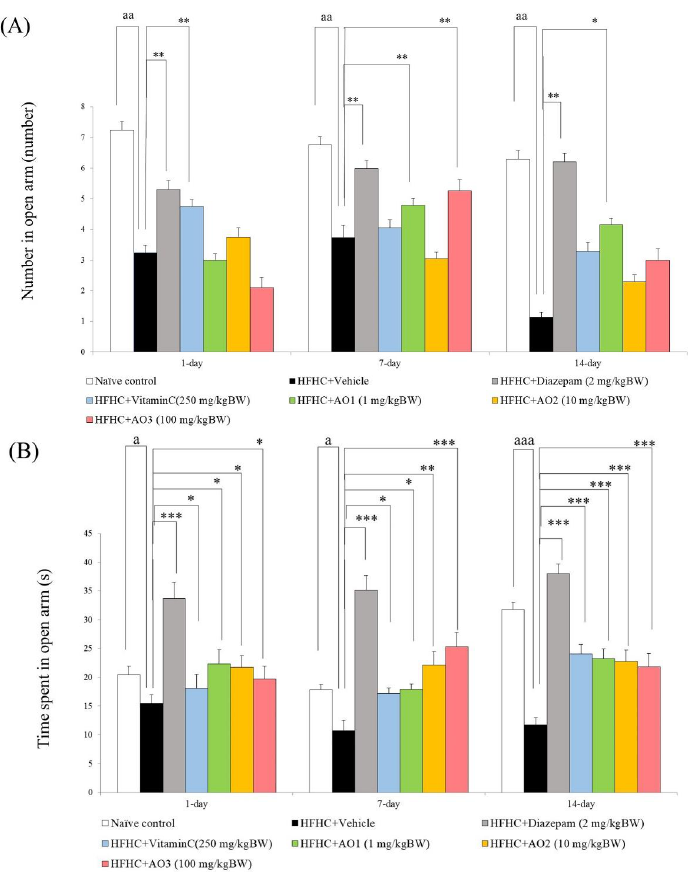
Figure 1. Anxiolytic effect of the functional ingredient containing cashew leaf extract and cashew apple pomace-derived dietary fiber (AO) assessed by using elevated plus maze test. ( A ) Number of open arm entries. ( B ) Time spent in an opened arm. Data are presented as mean ± SEM ( n = 6/group). a , aa , aaa p -value < 0.05, 0.01, and 0.001, respectively; compared to naïve control that received ND and vehicle and *, **, *** p -value < 0.05, 0.01, and 0.001, respectively, compared to metabolic syndrome rats induced by HFHC and received vehi- cle.